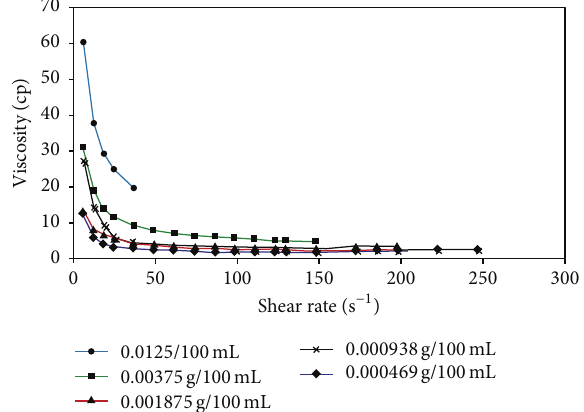
Figure 2: Shear rate versus viscosity for PAM-Sa at 20 ∘ C at different